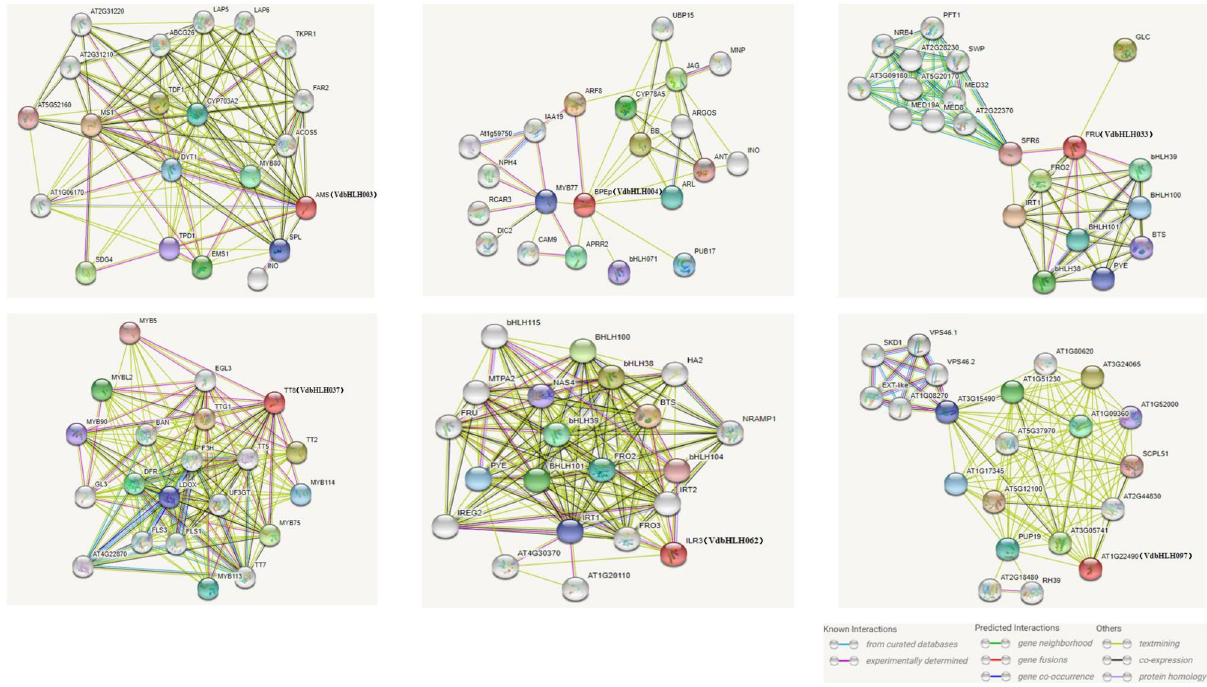
Figure 6. Interaction network analysis for VdbHLH003 , VdbHLH004 , VdbHLH033 , VdbHLH037 , VdbHLH062 and VdbHLH097 . Note : The predicted results are based on the orthologous gene in Arabidopsis . VdbHLH genes are shown in